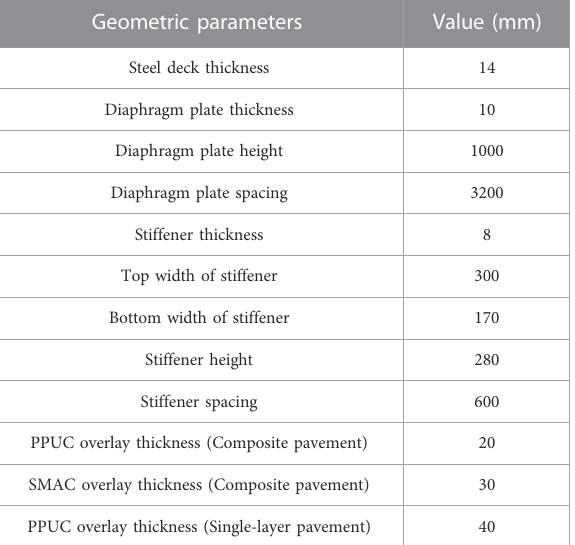
TABLE 5 Geometric parameters of the pavement structure model. Geometric parameters